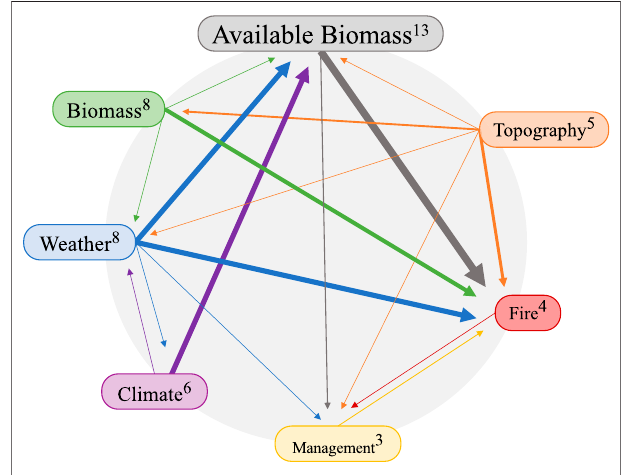
FIGURE 3 | Redrawn from Cawson et al. [34], this consensus diagram shows dominant themes and the strength and direction of relationships between those themes. The number after each theme and the font size indicate the number of times that theme appeared across all conceptual models. The links between the themes and the direction of those links are shown by the arrows. The weight of the arrow indicates the number of times that the link appeared across all